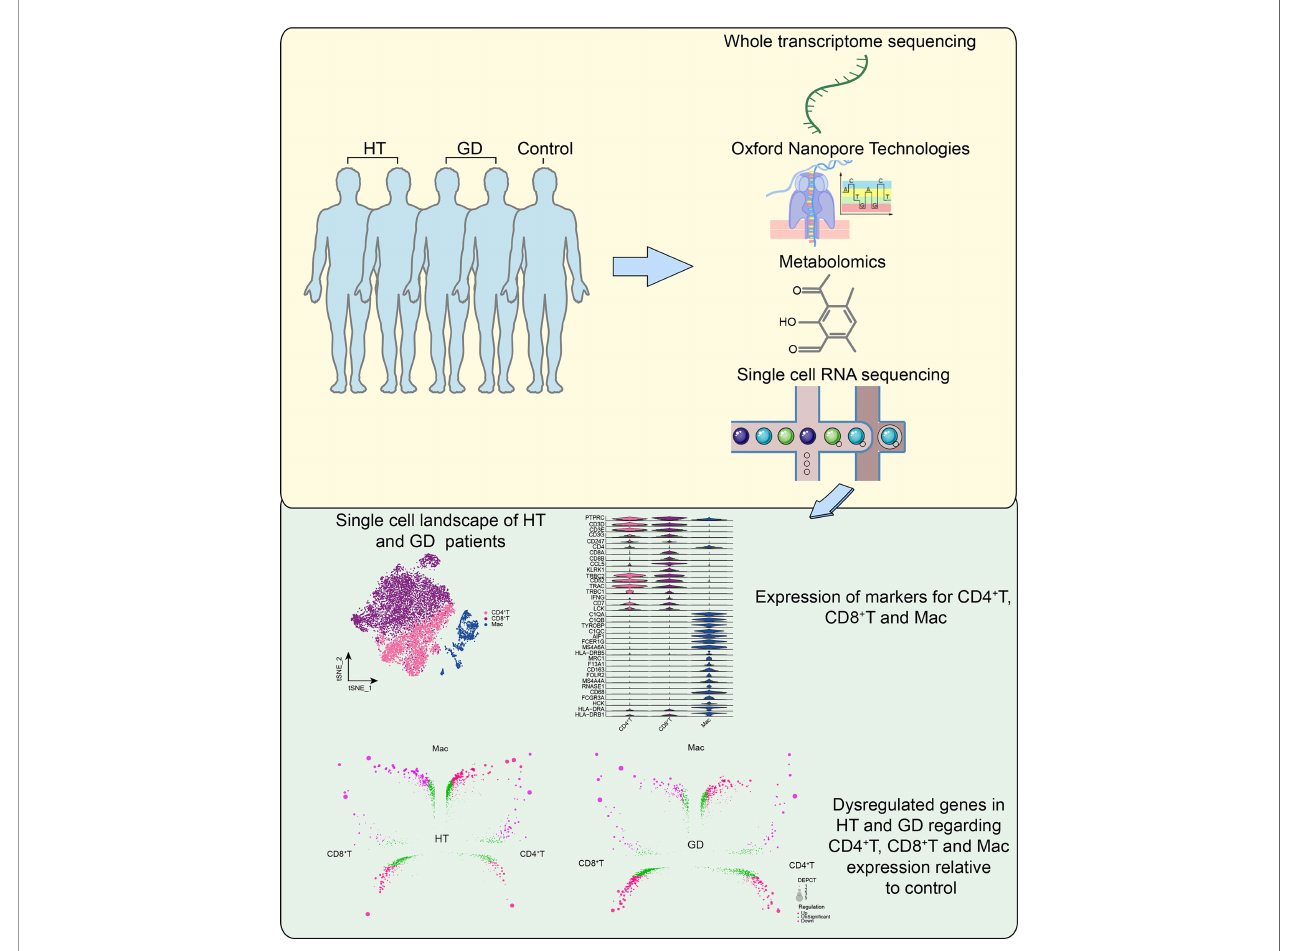
FIGURE 1 | Flowchart. GD, Graves ’ disease; HT, Hashimoto ’ s thyroiditis; Mac,